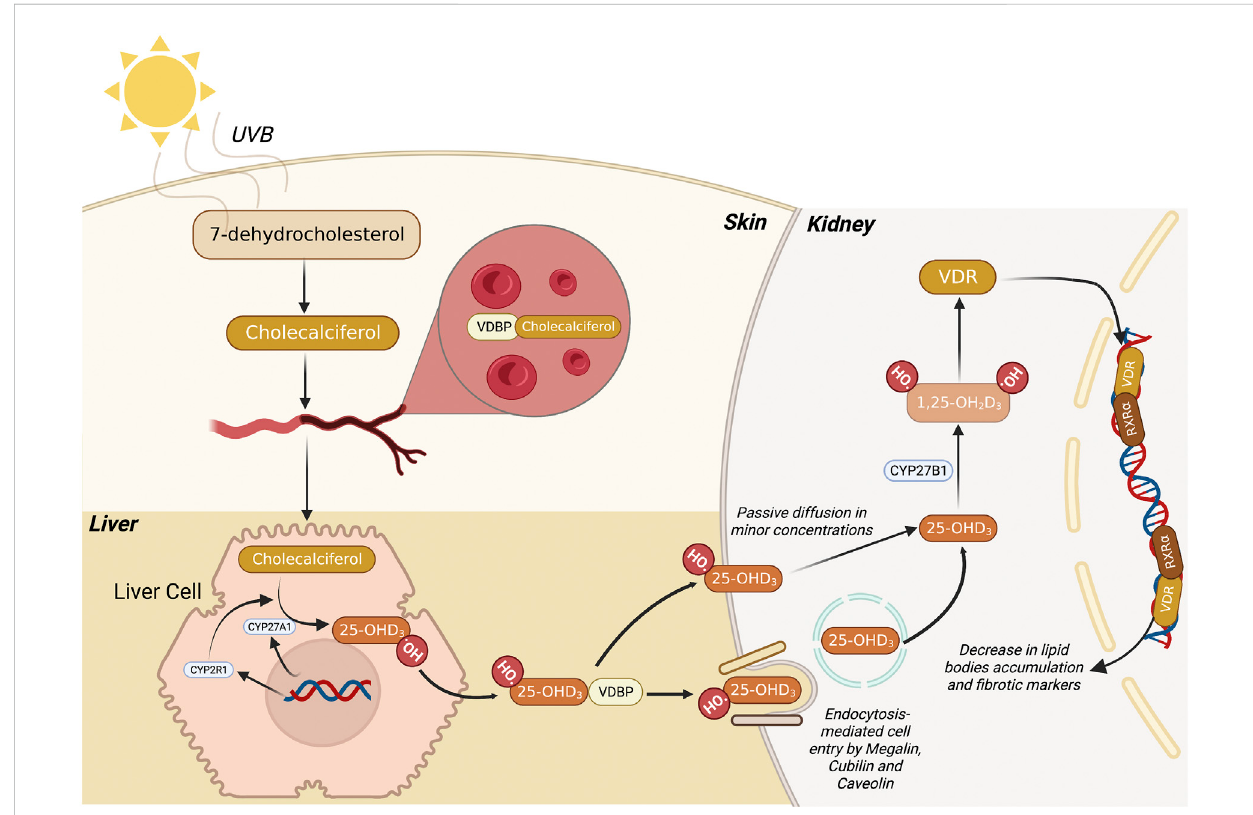
FIGURE 1 Metabolic route of 1,25 dihydroxyvitamin D3 synthesis. Firstly, 7-dehydrocholesterol (7-DHC) is converted to pre-vitamin D3 (Cholecalciferol) through the action of UVB light in the skin. Subsequently, this compound migrates to the bloodstream where it binds to VDBP, and the complex is transportedto theliver. Then, theliver cell promotesthe conversion ofpre-vitamin D3into 25-hydroxyvitamin D3 (25-OHD3) mediated by CYP27A1 and CYP2R1. Finally, 25-OHD3 migrates to the kidney where it can be passively diffused to the cells or be endocytosed via megalin, cubilin and caveolin membranereceptors.Once 25-OHD3reachesthecytosol,it isconvertedbyCYP27B1into 1,25dihydroxyvitaminD3(1,25D3), thebioactiveform ofVitD. Subsequently,the1,25D3bindsto VDR,migrate tothenucleus, andheterodimerizes withothernuclearhormones receptors, leadingto thetranscription ofgenesrelatedtolipidmetabolism.7-DHC,7-dehydrocholesterol;UVB,ultravioletB(radiation);VDBP,vitaminDbindingprotein;VitD,vitaminD.Figure created with